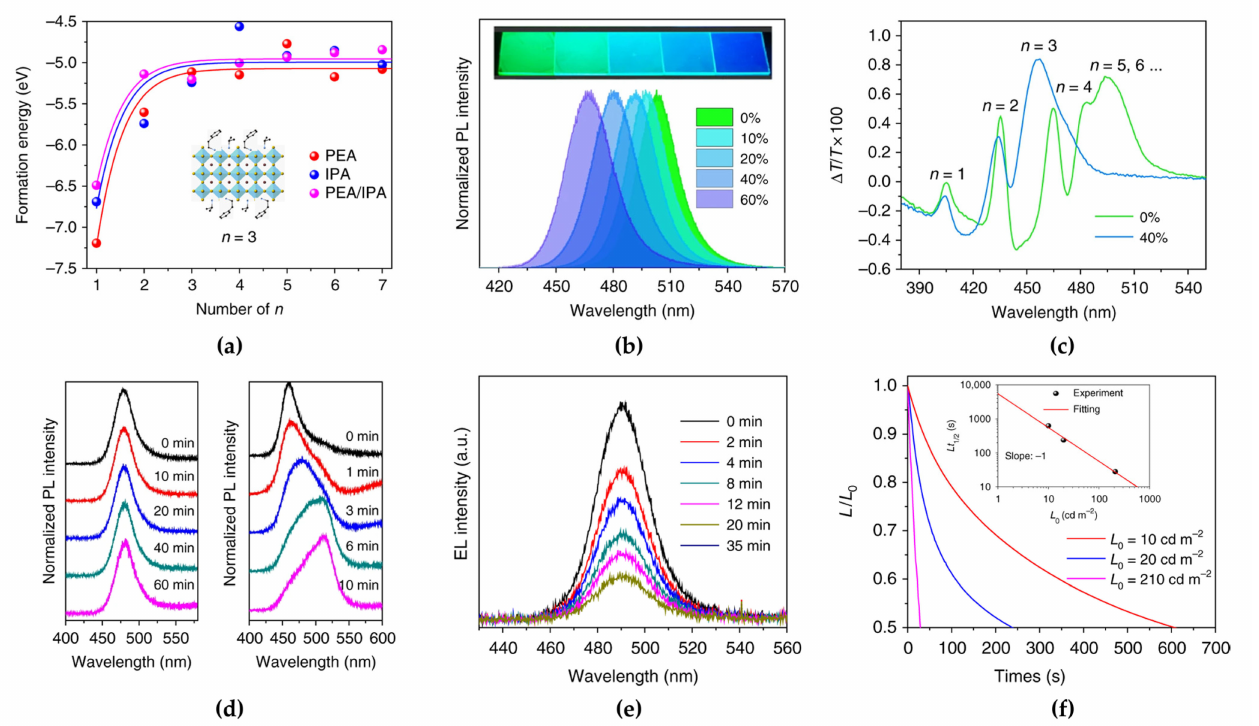
Figure 6. ( a ) Calculated formation energy of PEABr and isopropylammonium (IPA)Br-mixed quasi- 2D perovskites with different n values (inset: PEA/IPA-mixed quasi-2D perovskite with n = 3). ( b ) PL spectra of PEA 2 A 1.5 Pb 2.5 Br 8.5 with 0 − 60% IPABr. ( c ) Transient absorption (TA) spectra of PEA 2 A 1.5 Pb 2.5 Br 8.5 with 0% and 40% IPABr. ( d ) PL spectra of quasi-2D perovskite (left) and MAPbCl 1.5 Br 1.5 (right) films under continuous laser radiation (325 nm, 7 W/cm 2 ) at different exposure times. ( e ) EL spectra of PeLED vs. operation times. ( f ) Device half-lifetime of PeLEDs vs. different initial luminance (inset: estimated half-lifetime by stretched exponential decay). Reprinted with permission from [61], Copyright 2018 Springer